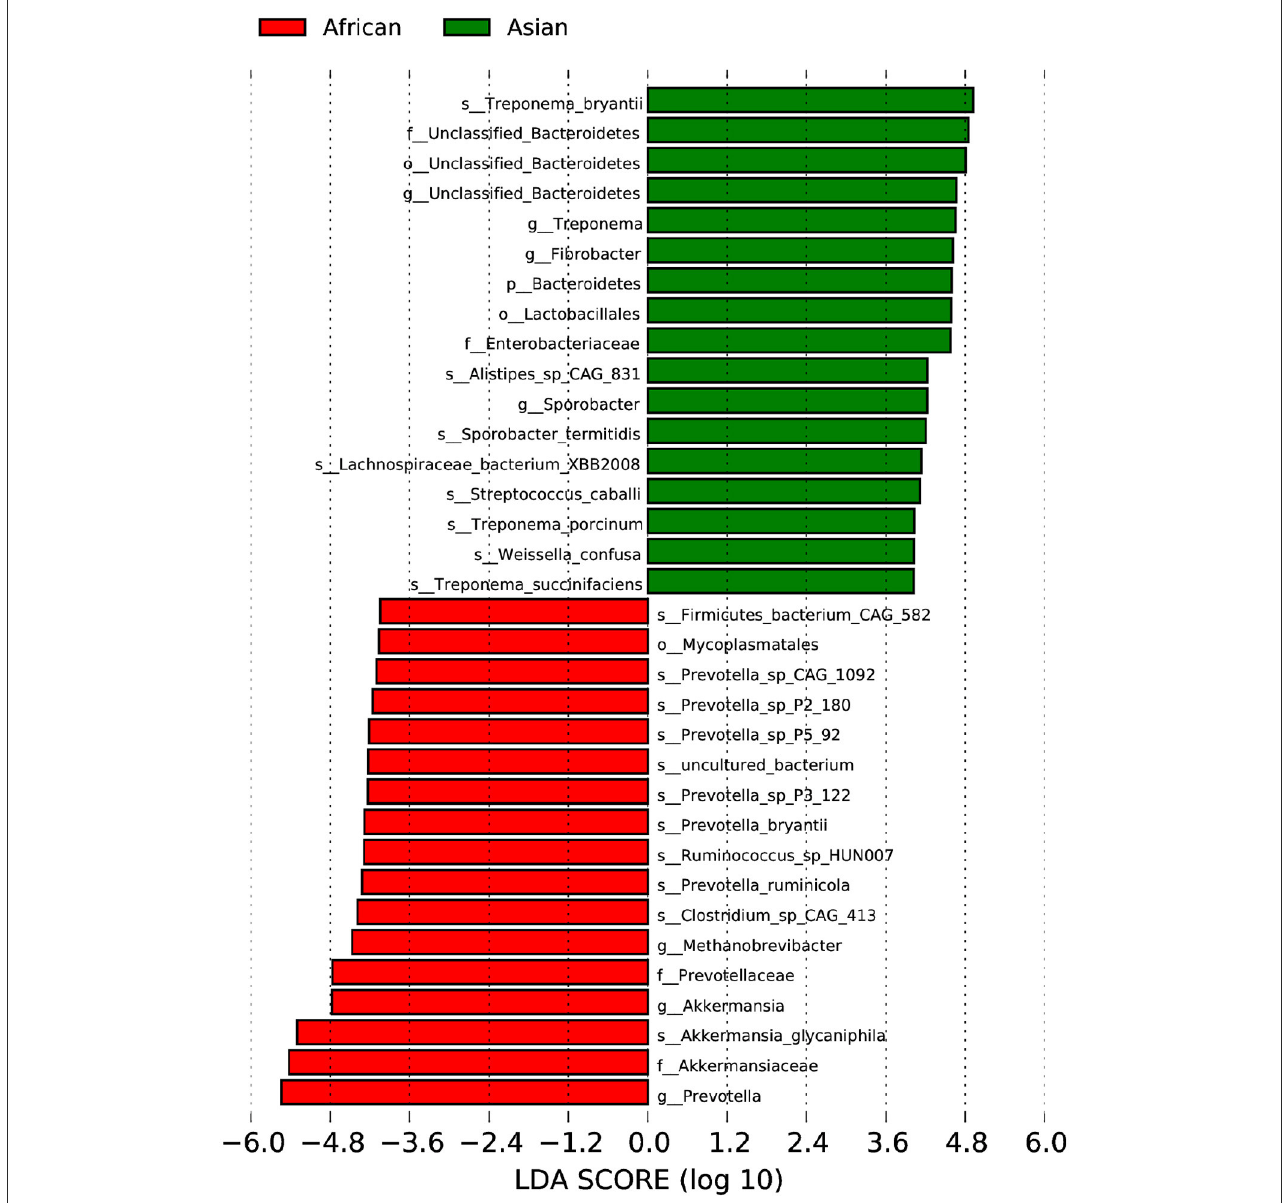
FIGURE4 LEfSe Analysis of Differential taxa between Groups is shown in the LDA value distribution histogram. The presented are biomarkers taxa enriched within each group (LDA > 4). The length of the histogram (LDA score) represents the effect size of each abundant taxa.